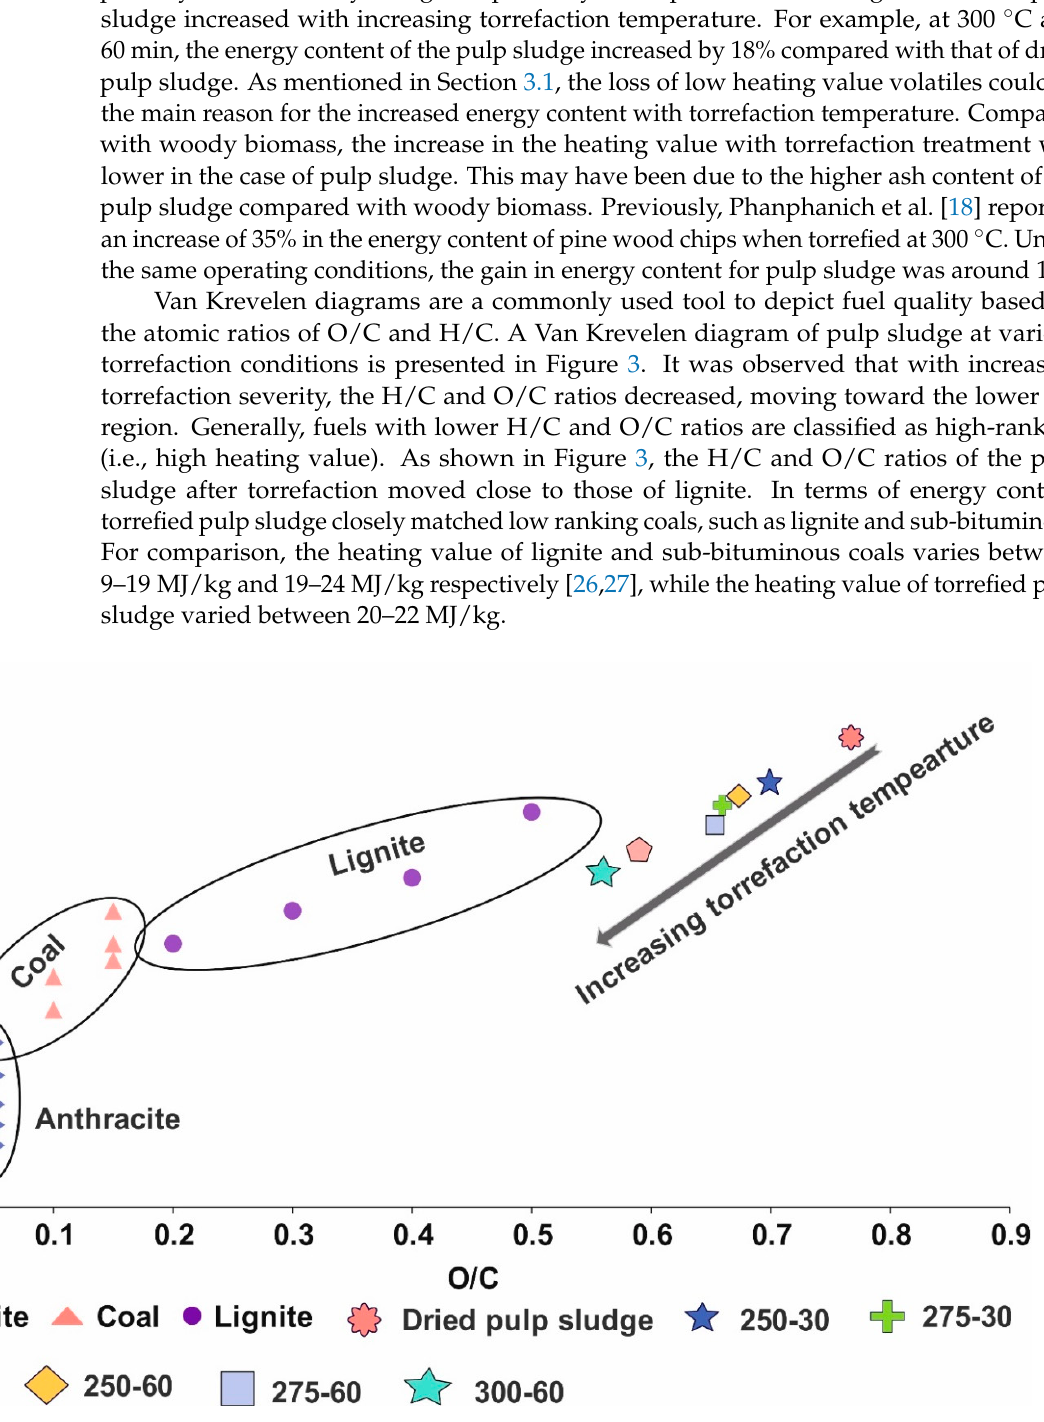
Figure 3. Van Krevelen diagram of dried and torrefied sludge. The data for anthracite, coal and lignite are from [28].